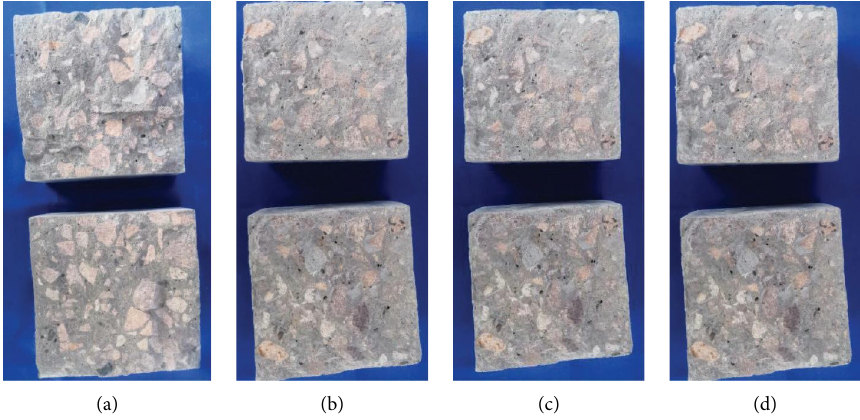
Figure 6: Splitting tensile test destruction interface. (a) SAC. (b) LSAC-10. (c) LSAC-20. (d)